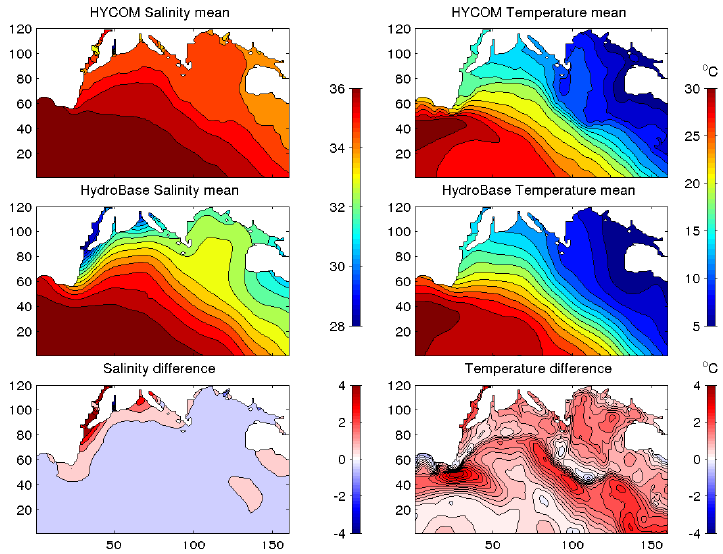
Figure 2. Comparisons of surface (layer 36) salinity and temperature fields between HYCOM/NCODA (top panels) and HydroBase (mid- panels), and their misfits (bottom panels). x and y axes denote grid numbers of the